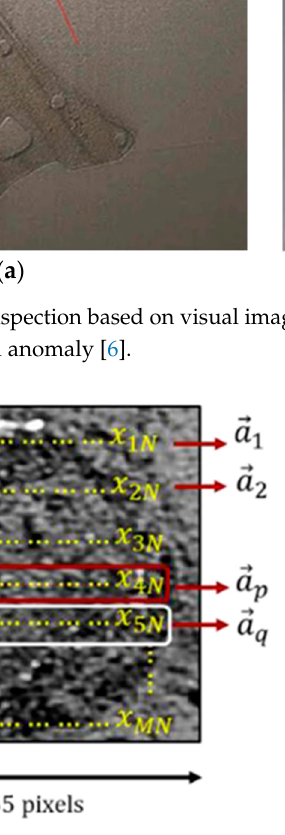
Figure 15. Diagram of linking features and process parameters using machine learning methods [62].